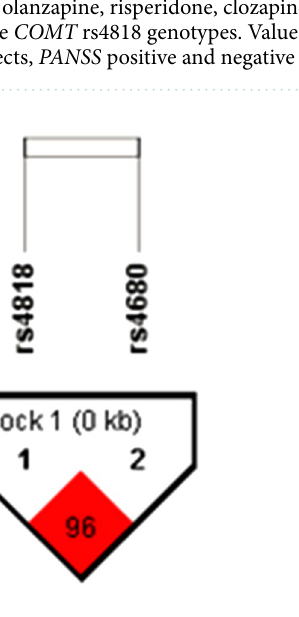
Figure 1. Linkage disequilibrium (LD) plot for two COMT SNPs in schizophrenia patients. Pairwise LD value (D’ × 100) is calculated using 4-gamete rule and represented in red square. Revealed D’ value indicates a strong link between rs4818 and rs4680